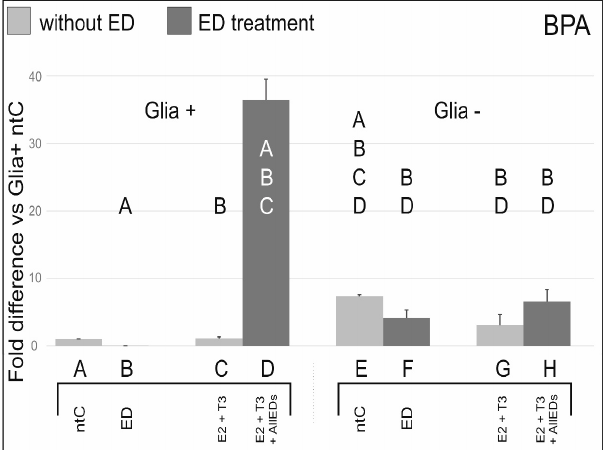
Figure 1. Effects of bisphenol A (BPA) with, and without, 17beta-estradiol (E2) and triiodo-thyronine (T3), on ER β mRNA expression. BPA treatment decreased ER β mRNA expression compared to the non-treated control. In glia-reduced cultures (Glia − ), a more than two orders of magnitude higher (×180) ER β mRNA expression was found in BPA treated cultures (column B vs. F). In glia containing samples (Glia+), there was about three magnitudes higher ER β mRNA expression after E2 + T3 + BPA (column D) treatment than after BPA treatment alone (column B). Letters in and above the columns indicate significant differences ( p ≤ 0.05) from columns below.